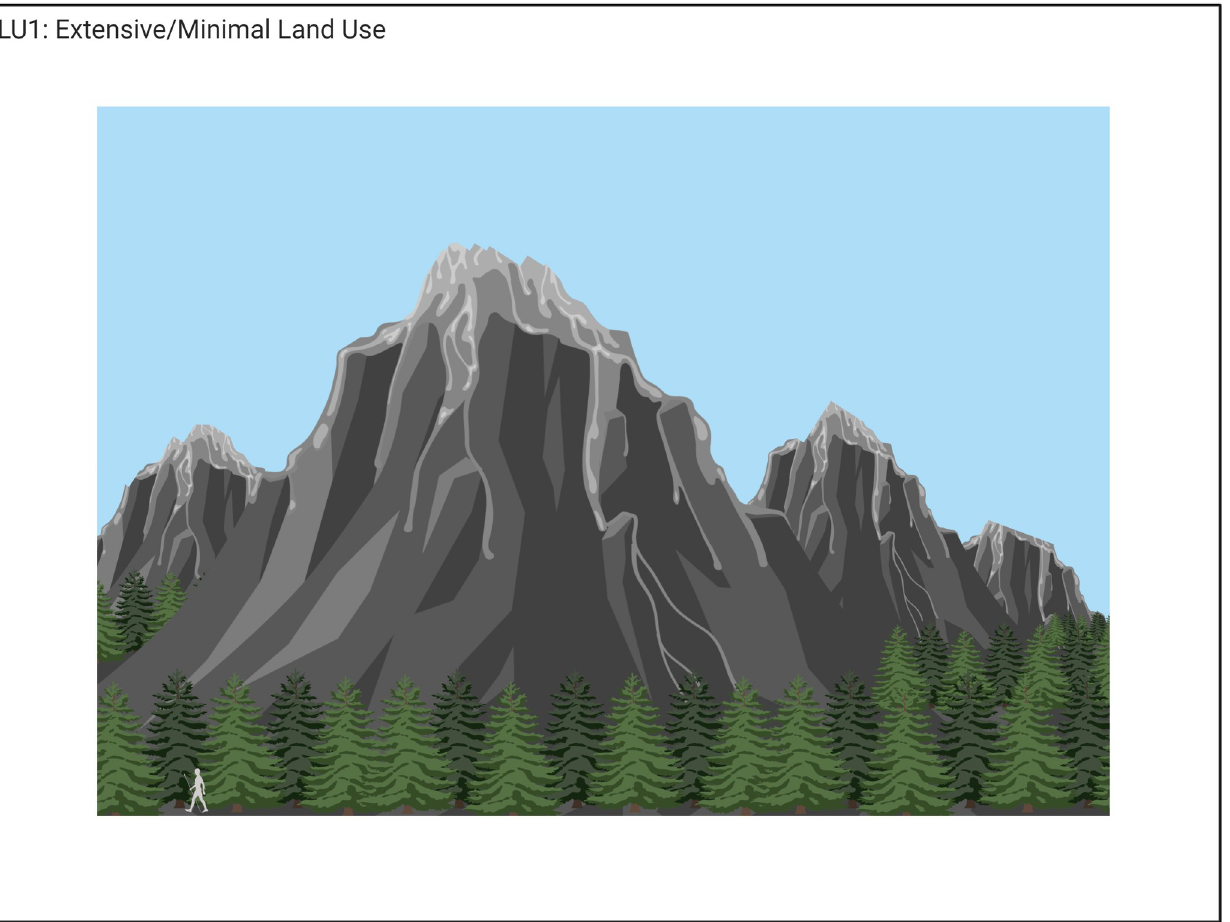
Fig 3. Mountain ranges with access routes or evidence of exploration but not inhabitation representing LU1-“extensive-minimal”. Created with BioRender.com, under a CC BY license, with permission from Biorender, original copyright 2020.